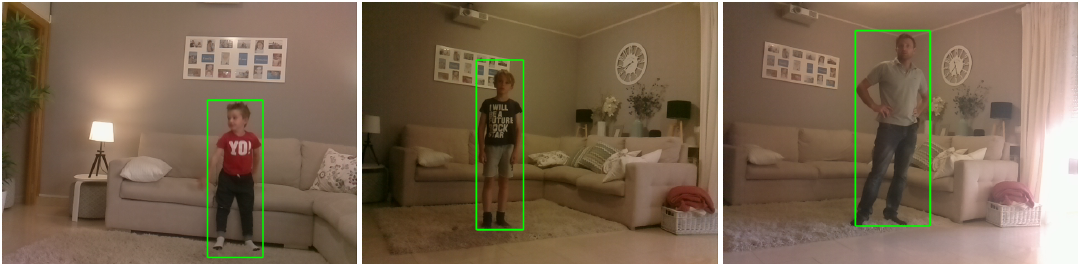
Figure 9. FPDS images with different person sizes—1.2, 1.4 and 1.8 m height. Images were taken in eight different environments with variable illumination, as well as shadows and reflections, defining eight splits. Figure 10 and Table 2 show sample images and the characteristics of the FPDS, respectively.